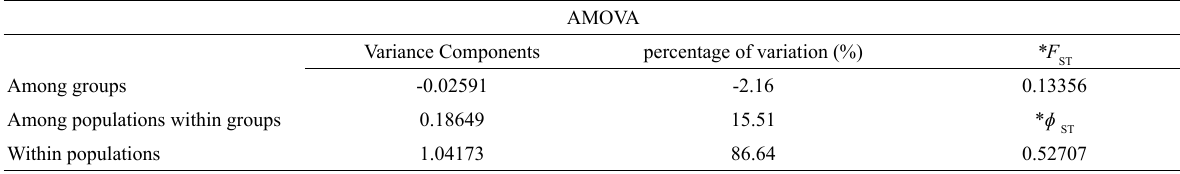
Table 3 – Analysis of molecular variance (AMOVA).